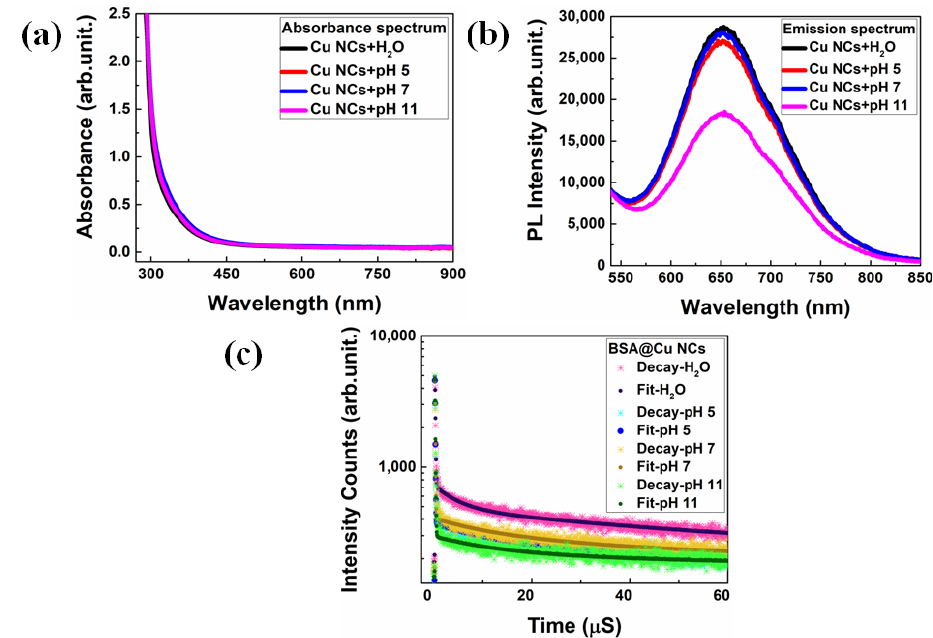
Figure 3. The effect of buffer solutions (pH 5, 7, 11) on the optical properties of BSA-Cu NCs. ( a ) No sharp SPR peak observed after the addition of buffers to the BSA-Cu NCs. ( b ) The emission intensity gradually decreased due to the presence of pH 7 buffer solution to the NCs. ( c ) The radiative decay patterns also followed the decrement trend in the NCs after incorporating different buffers.